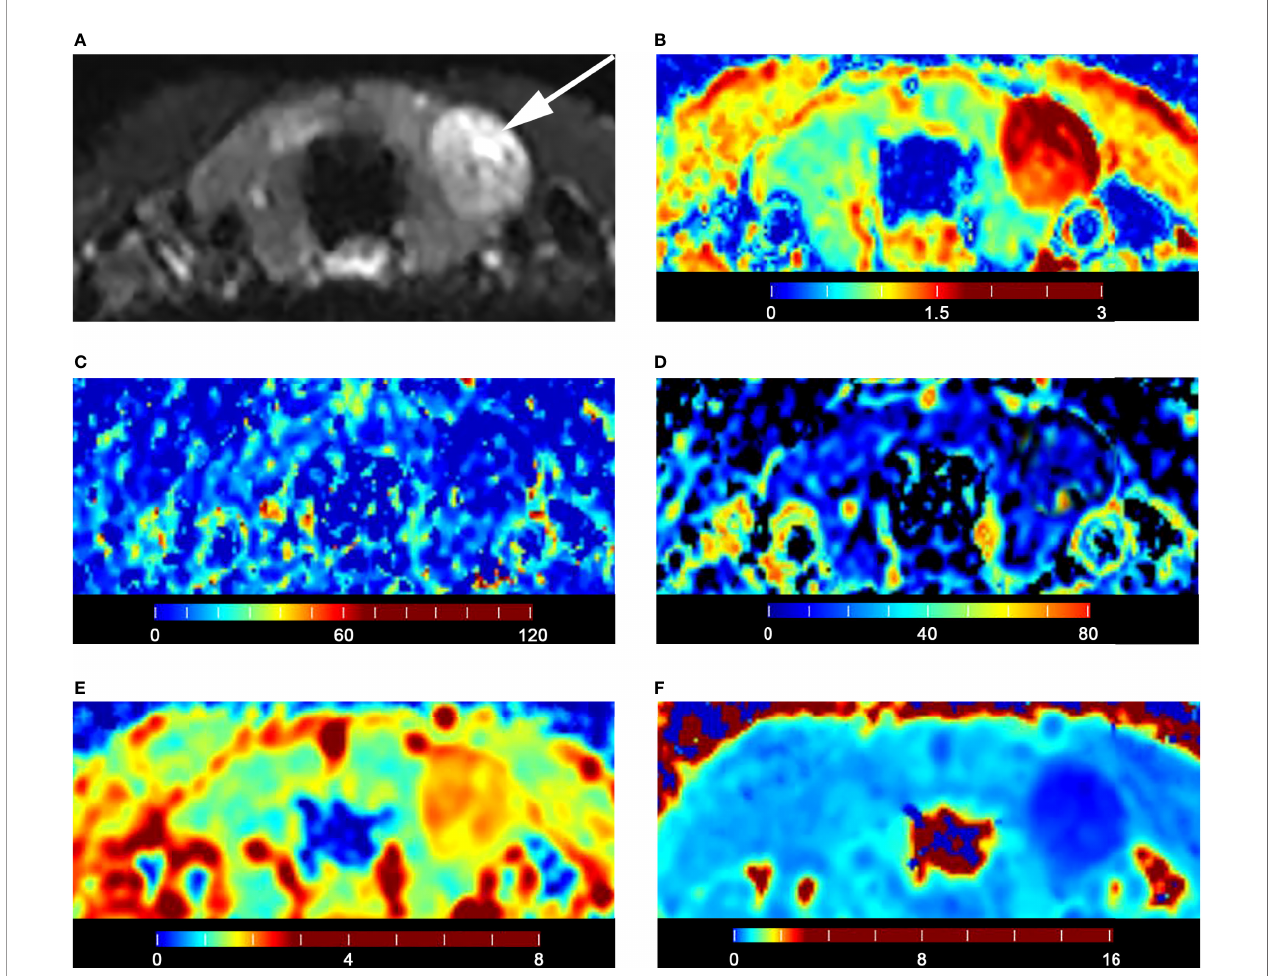
FIGURE 3 | Images of a 28-year-old male with left lobe follicular adenoma: (A) axial diffusion image with b = 0; (B) color map of D, D value of lesion is 1.79 × 10 -3 mm 2 /s; (C) color map of D*, D* value of lesion is 15.74 × 10 -3 mm 2 /s; (D) color map of f, f value of lesion is 18.35%; (E) color map of D app , D app value of lesion is 2.06 × 10 -3 mm 2 /s; (F) color map of K app , K app value of lesion is 0.50.